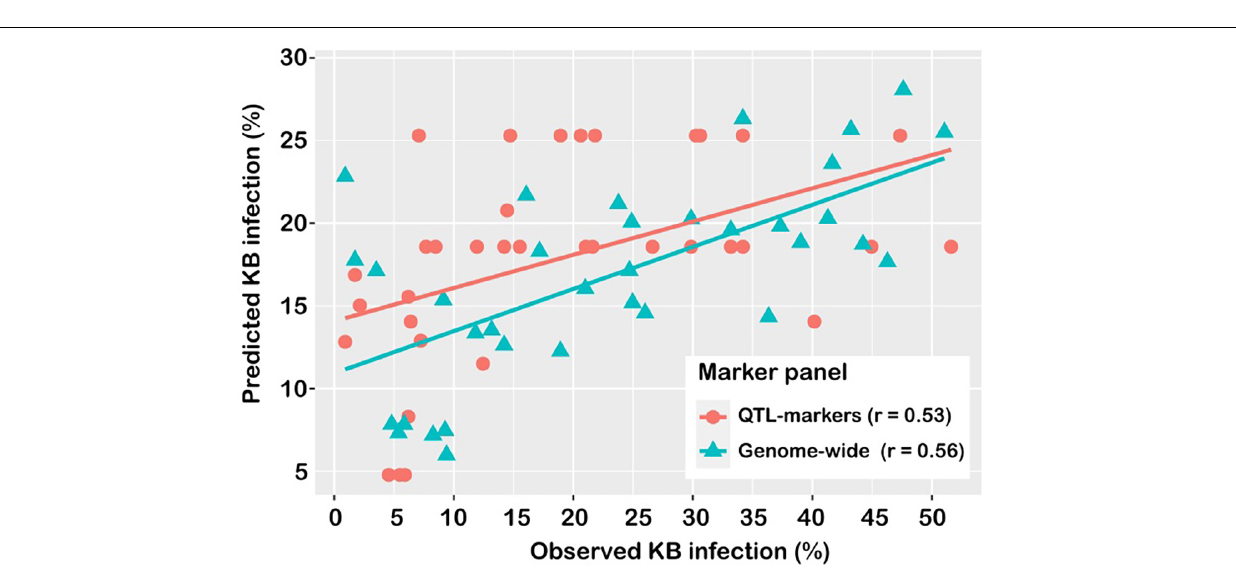
r 2 values of unlinked markers was 0.15, which agrees with the value commonly reported for wheat (Joukhadar et al., 2020). This value intersected the LD decay line at 62.5 Kbp ( Figure 2 ), and